Question: Condense the content of this figure into a single sentence.
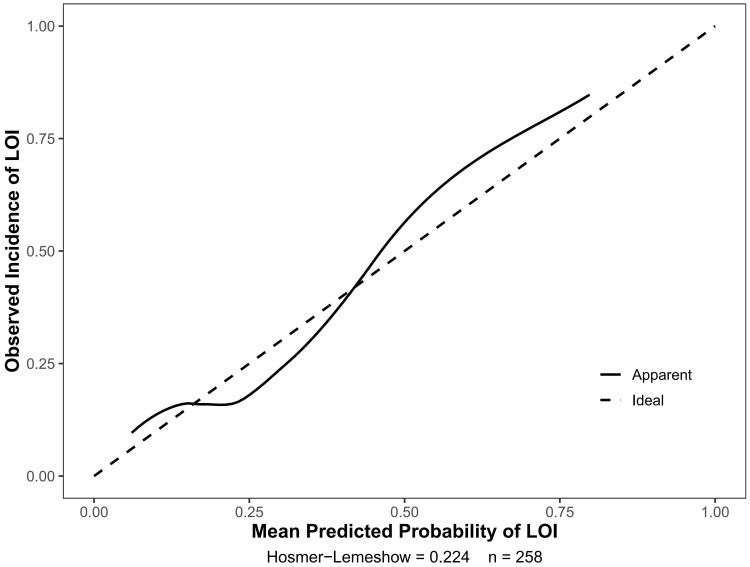
Answer: Calibration curve for the prediction model of postoperative LOI.